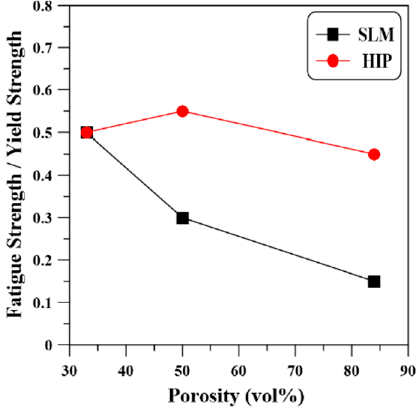
Figure 10. Porosity influence on the fatigue endurance ratios at 10 ⁶ cycles of as-built and specimens subject to Hot Isostatic Pressing (HIP). Reproduced from [71], with permission of Elsevier, 2020.